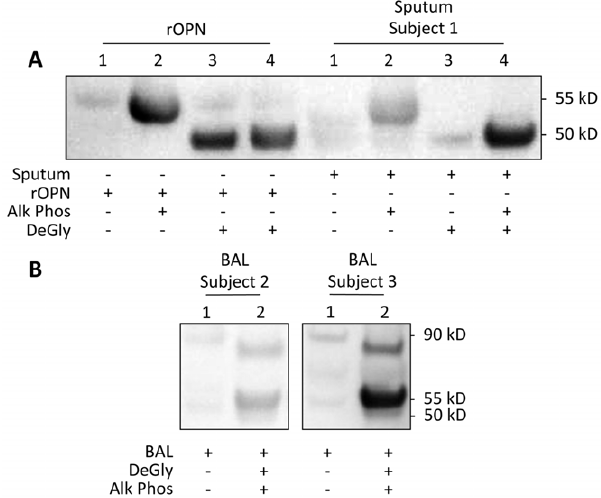
Figure 2. Deglycosylation and dephosphorylation of rOPN and BAL and sputum sOPN. Immunoblot of deglycosylation and dephosphorylation of rOPN and sputum supernatant sOPN ( 2A ) and BAL fluid sOPN from representative subjects ( 2B ) probed with polyclonal anti-human sOPN antibody. DeGly: Deglycosylation Enzyme Mix; Alk Phos: Alkaline Phosphatase.